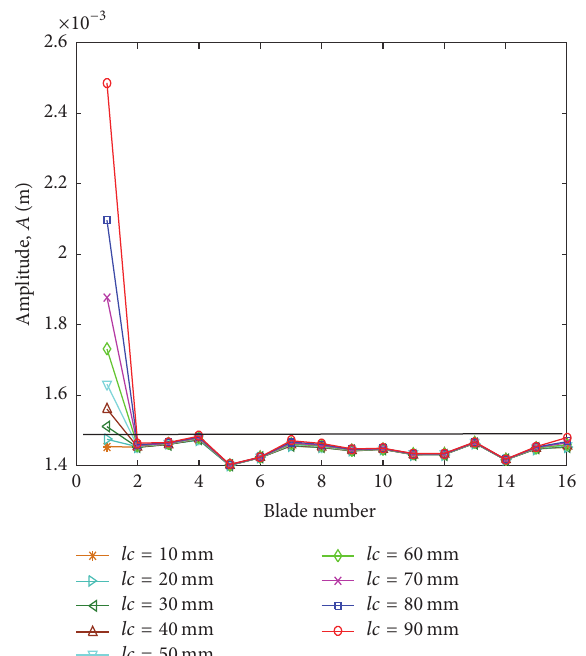
Figure 16: Vibration amplitudes of MRBs under different 𝑙𝑐 .